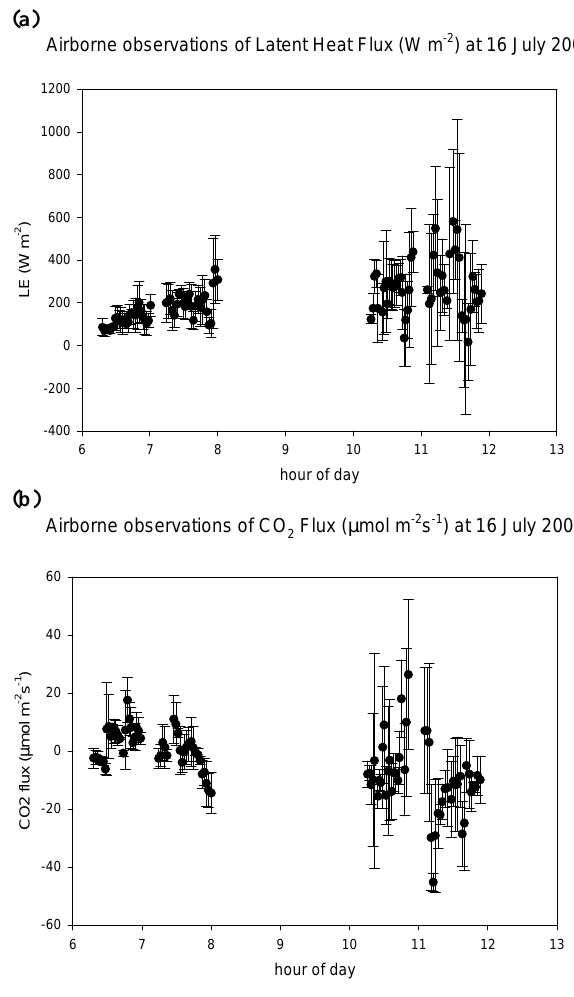
Fig. 11. Airborne observations of latent heat flux (Wm − 2 ) and CO 2 flux (µmolm − 2 s − 1 ) for 16 July 2002. The error bars represent the 95% confidence interval.